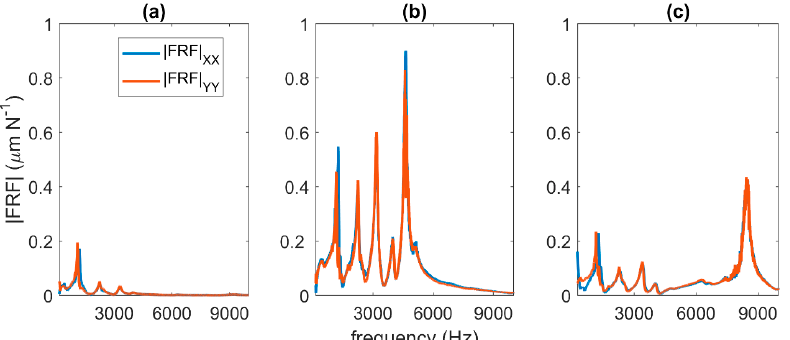
Figure 3. Dynamic properties at the tool tip. ( a ) Rigid shoulder mill Walter F4042 of 50 mm diameter. ( b ) End mill Iscar E90AN, 16 mm diameter, 50 mm overhang. ( c ) End mill Iscar E90AN, 16 mm diameter, 30 mm overhang.